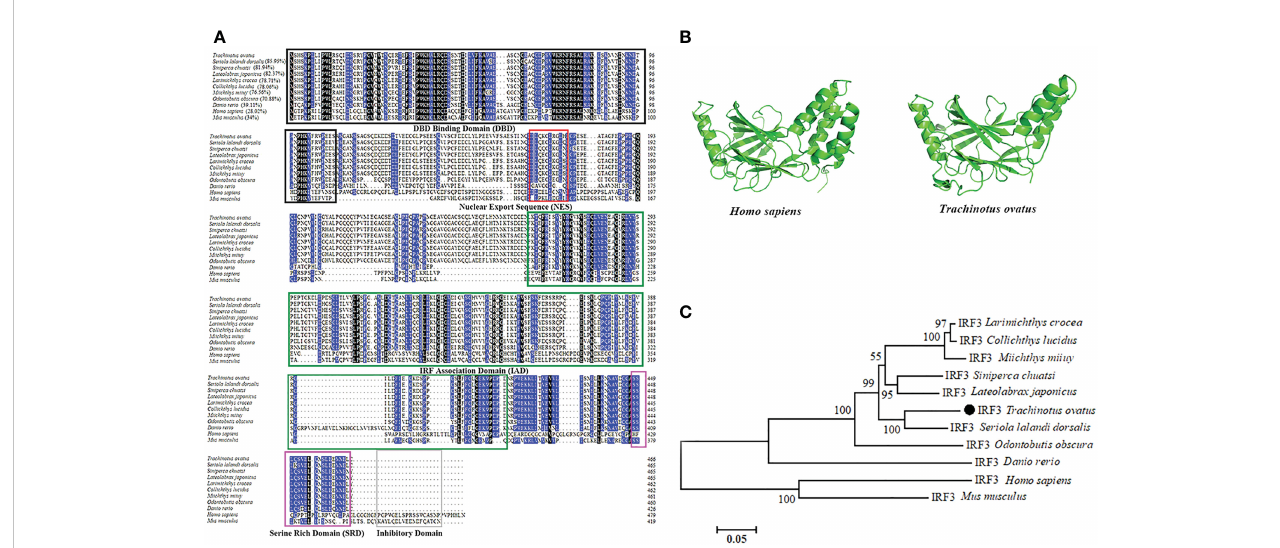
FIGURE 1 Sequence characteristics of TroIRF3. (A) Alignment of amino acid sequences from TroIRF3 and other IRF3 homologs. Identities between TroIRF3 and the compared sequences are shown in brackets. The background color of amino acid residues corresponds to the conservation degree (blue > 75%, black = 100%). The conserved DBD domain is boxed in black, the conserved IAD domain is boxed in green, the conserved SRD domain is boxed in purple, and the conserved inhibitory domain is boxed in gray. The nuclear export sequences (NES) are marked with the red box. (B) Analysis of the SWISS-MODEL prediction for TroIRF3 (SWISS-MODEL Template ID: 5jek.2) compared to human IRF3. (C) Phylogenetic analysis of TroIRF3. MEGA 6.0 was used to construct a phylogenetic tree based on neighbor-joining (NJ). The sequences of TroIRF3 genes used in this study were obtained from GenBank, a list of GenBank accession numbers can be found in Table